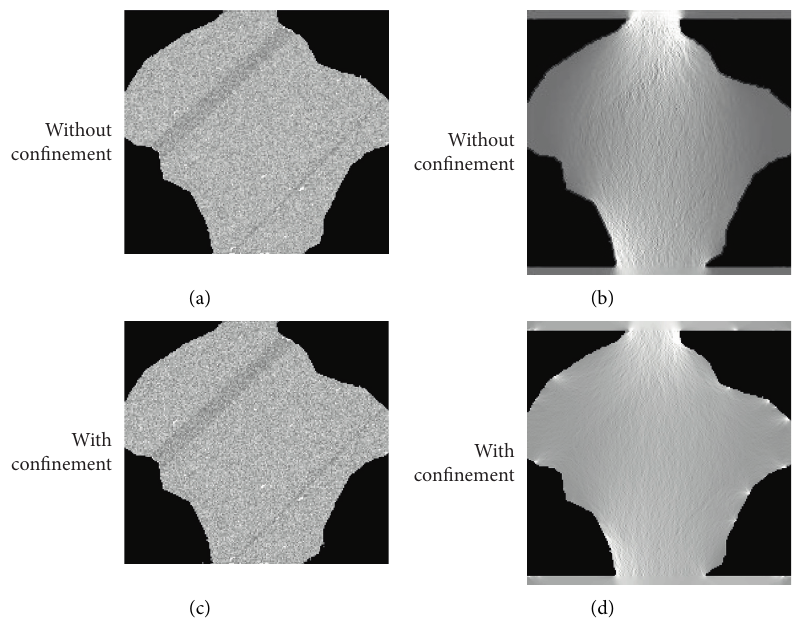
Figure 7: Distribution of the elastic modulus and maximum principal stress of the specimen during the initial loading.